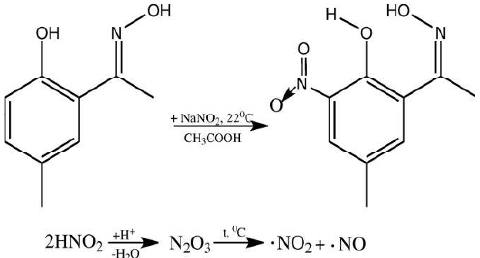
Scheme 1. Formation of (Z)-1-(2-hydroxy-5-methyl-3-nitrophenyl)- et hanone oxime ( I ) from the ( E )-1-(2-hydroxy-5- methylphenyl)ethanone